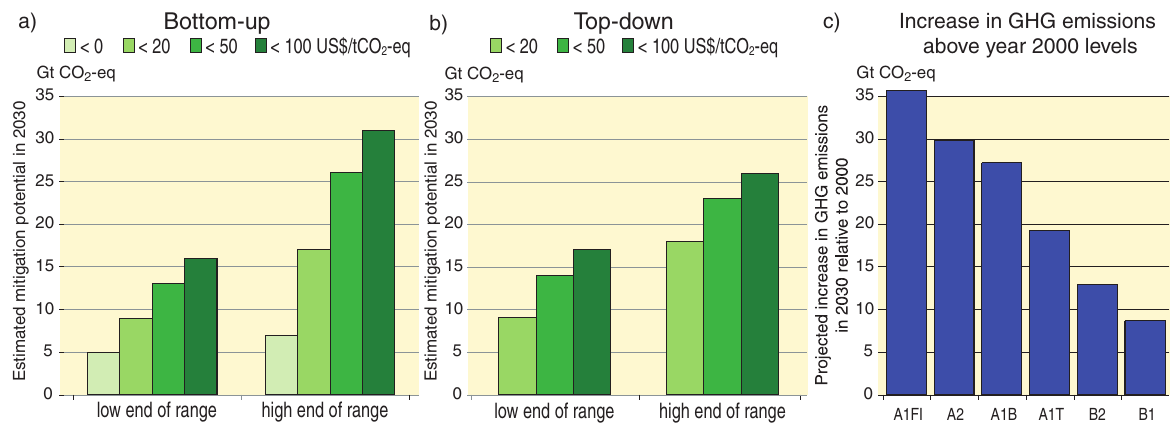
-eq (Panel c). Note: GHG emissions 2